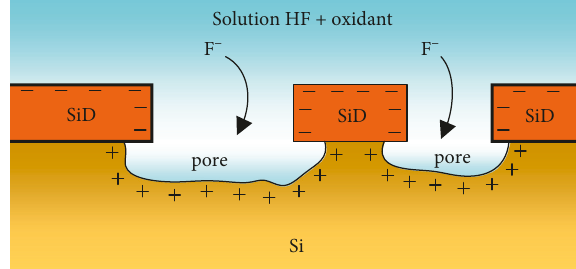
Figure 3: Scheme of silicon etching in solutions of